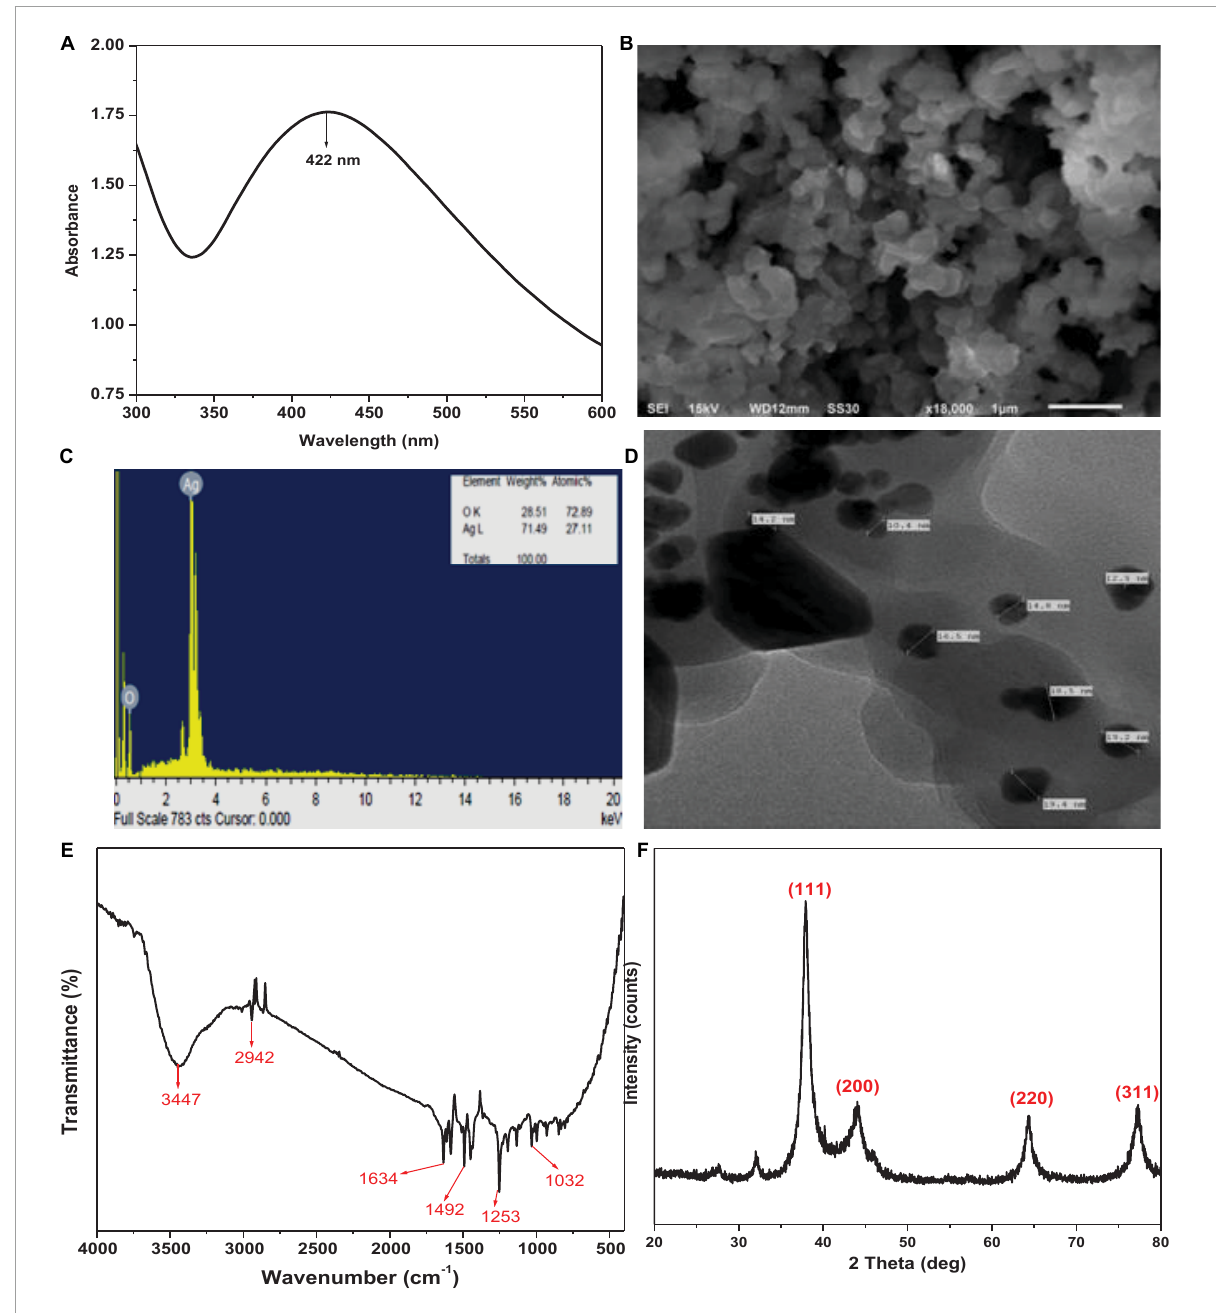
FIGURE1 Characterization of Cassia fistula leaf synthesized silver nanoparticles (Ag@ Cf L-NPs): UV–vis spectra of Ag@ Cf L-NPs (A) , scanning electron micrographs (SEM) of Ag@ Cf L-NPs (B) , EDX spectrum showing the histogram of wt% of major elements in Ag@ Cf L-NPs (C) , transmission electron micrographs (TEM) of Ag@ Cf L-NPs (D) , FTIR spectrum of Ag@ Cf L-NPs (E) and XRD pattern of powdered Ag@ Cf L-NPs (F)